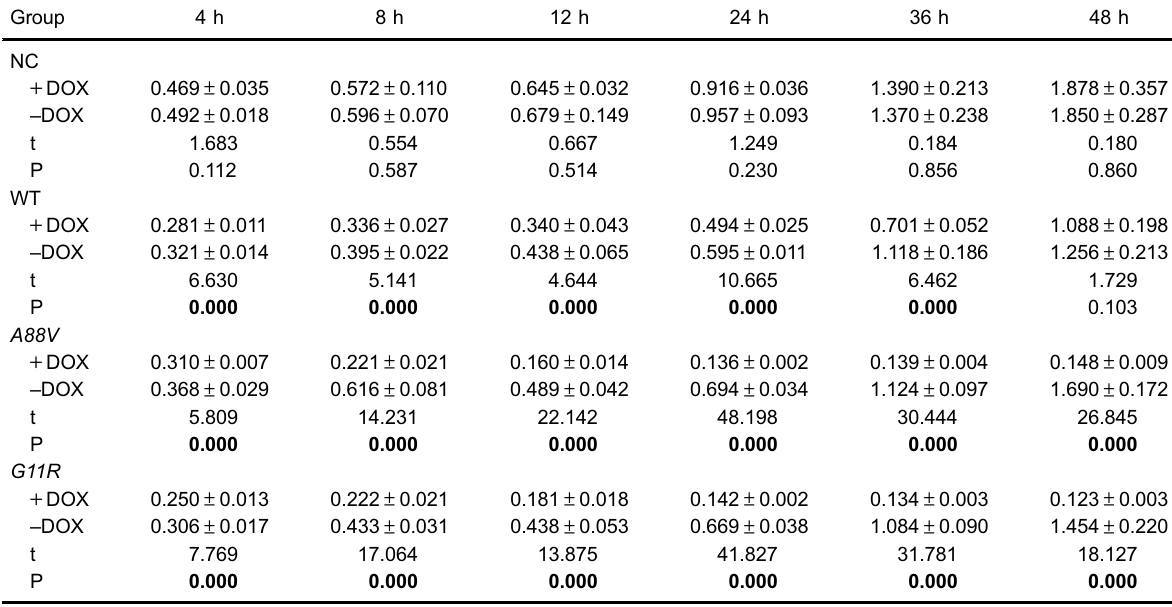
Table 1. Cell growth inhibition evaluated by CCK8 analysis of HaCat cells induced or not by doxycycline ( + DOX, and – DOX).